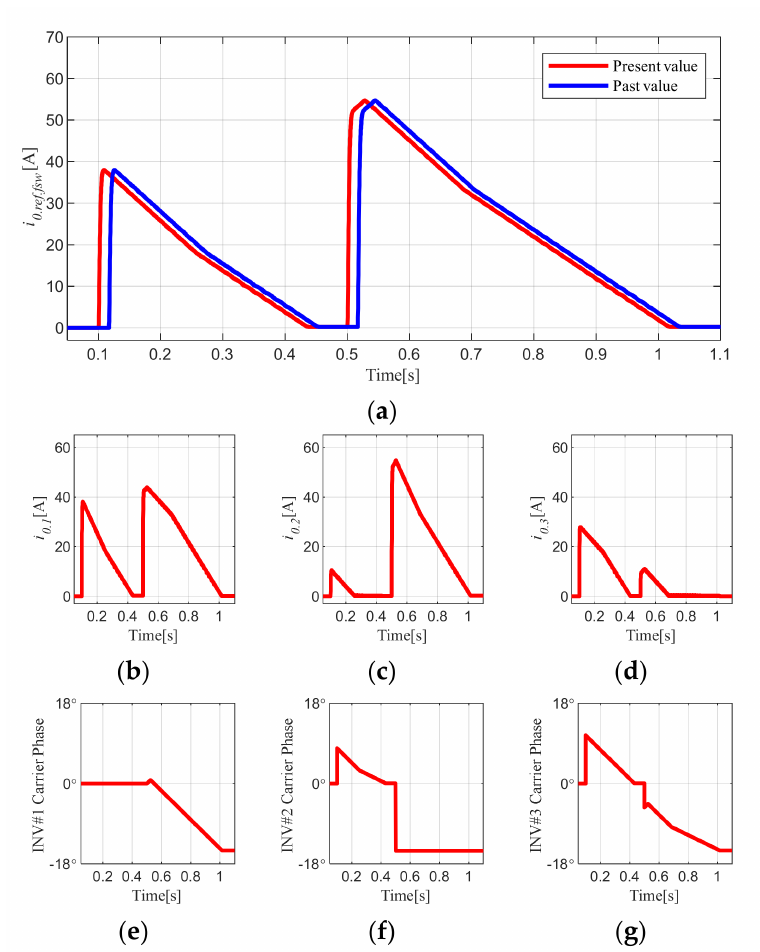
Figure 10. Results of simulation of control for phase errors occurring during normal operation 2 ( a ) trend of reference zero − sequence current, ( b ) trend of zero − sequence current of inverter 1, ( c ) trend of zero − sequence current of inverter 2, ( d ) trend of zero − sequence current of inverter 3, ( e ) carrier phase of inverter 1, ( f ) carrier phase of inverter 2, ( g ) carrier phase of inverter